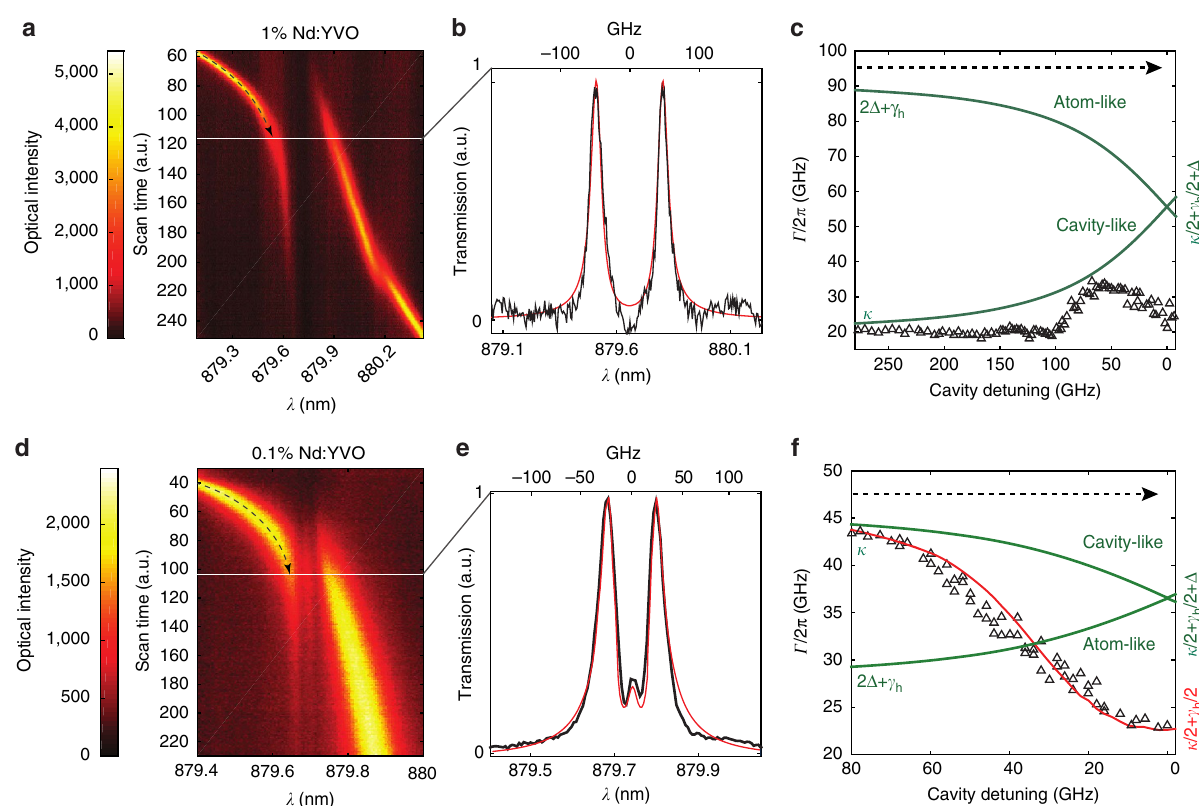
Figure 2 | Cavity protection of Nd ensembles against decoherence. ( a , d ) Cavity transmission spectra while tuning its resonance across the inhomogeneous Nd transition. ( b , e ) On-resonance transmission spectra showing two bright polaritons. Red curves are the theoretical fit assuming Gaussian ensembles. ( c , f ) Experimental decay rates extracted from the left anti-crossing trajectory (dotted arrows) in a and d , respectively, as a function of detuning. In c (1% Nd:YVO), the polariton (21GHz) is significantly narrower than the initial inhomogneous broadening (76GHz), but it is not reaching the full protection limit likely due to an asymmetric, non-Gaussian ensemble shape. In f (0.1%), the polariton linewidth decreases rapidly towards resonance to the full protection limit ( k /2 þ g h /2). Red curve plots the theoretial decay for a Gaussian distribution. Green curves show the theoretical decays assuming a Lorentzian ensemble of the same D